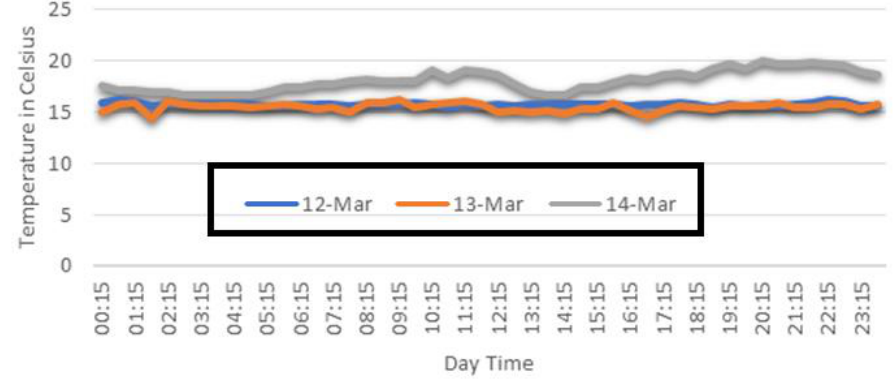
Figure 6. Daily temperature measurements in a classroom.